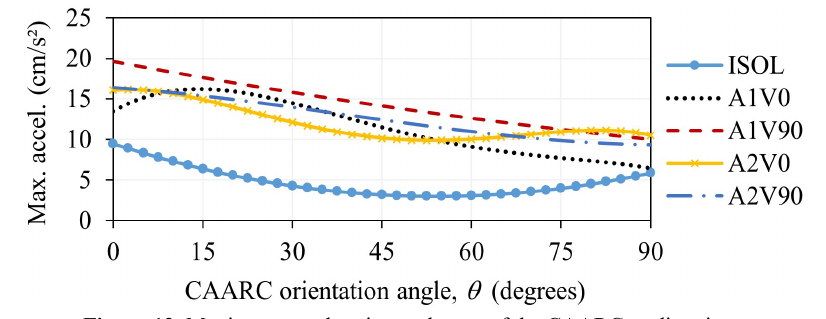
Figure 12. Maximum acceleration at the top of the CAARC, y-direction.